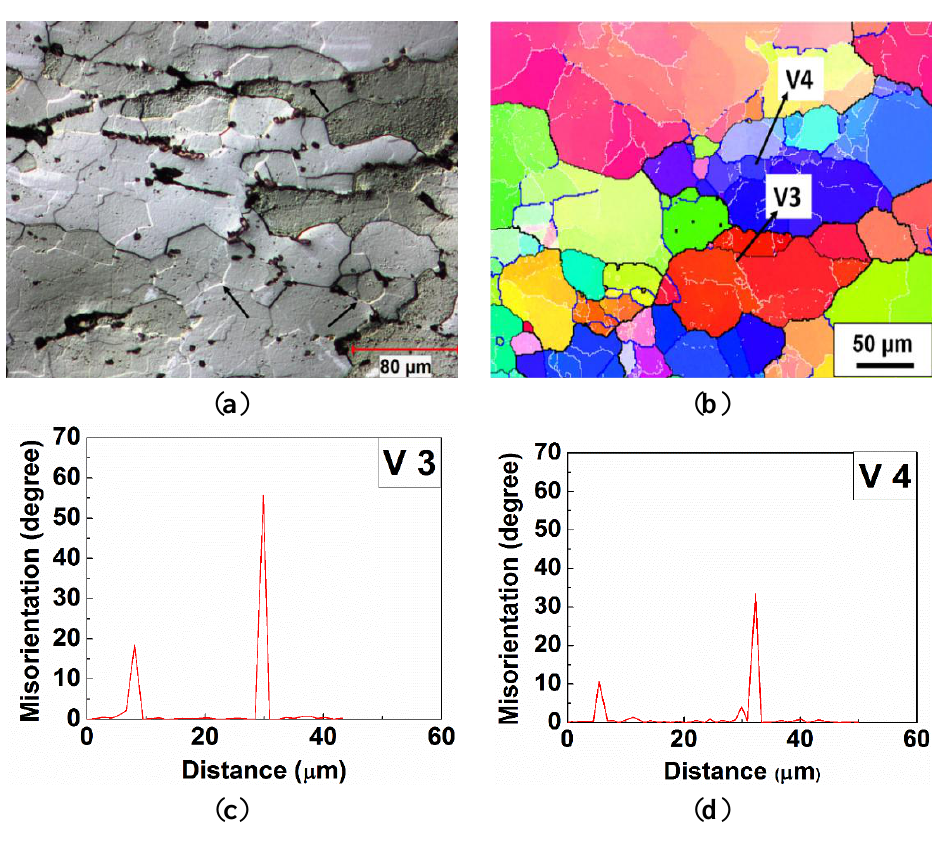
Figure 8. Deformed microstructures under deformation condition at 450 °C, 0.001 s −1 : ( a ) optical micrograph; ( b ) orientation imaging map; ( c ) a misorientation profile along vector V3; and ( d ) a misorientation profile along vector